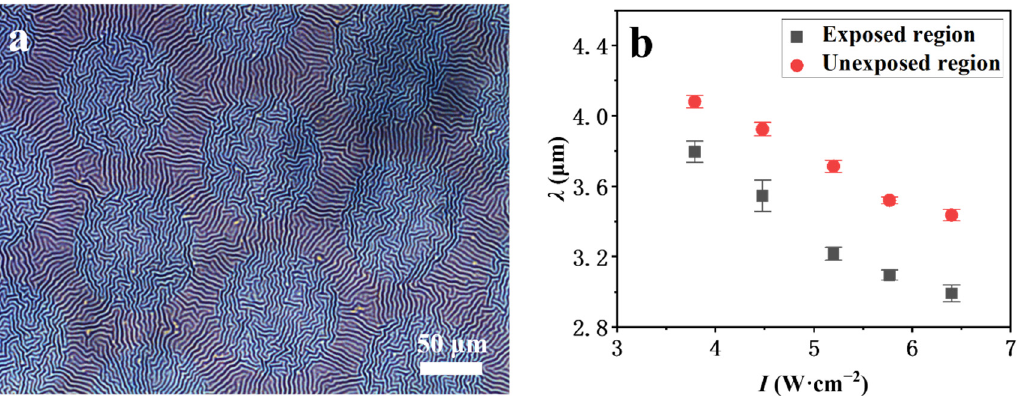
Figure 3. ( a ) Optical images of wrinkles of (3%PDO 3 -1%PS)/PDMS ( h f = 26 nm) induced by selective exposure (e.g., t = 30 s) through the copper grid (R200) on I = 6.40 W·cm − 2 . ( b ) The dependence of the wavelength ( λ ) of the wrinkles of exposed/unexposed region on the applied light intensity ( I ). Scale bars: 50 μ m.